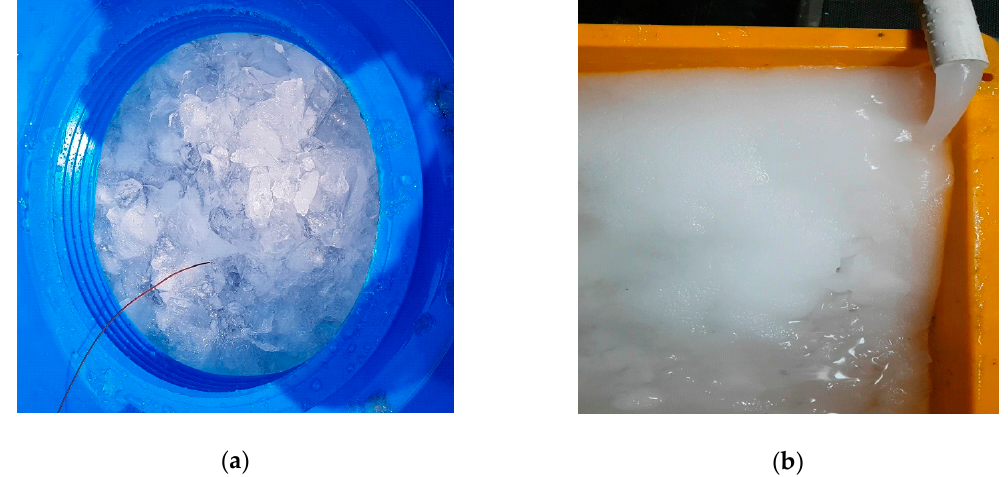
Figure 1. Photograph of crushed ice and ice slurry: ( a ) Crushed freshwater ice; ( b ) Seawater ice slurry.